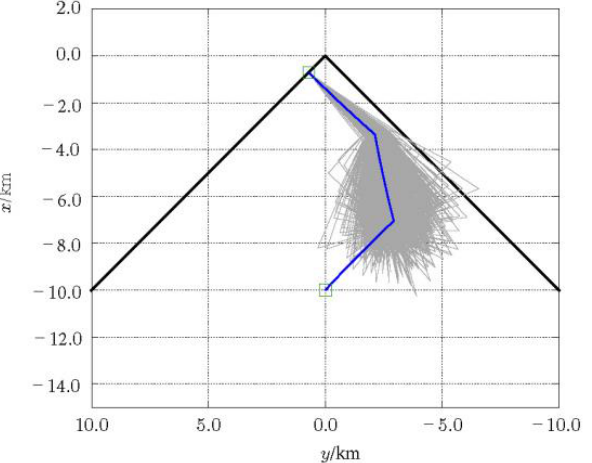
Figure 15. Robust guidance with the SaG strategy case: the Monte Carlo sample trajectories have a spatial deviation from the nominal trajectory and the robust guidance gradually absorbs the large trajectory deviation caused by the drift of the SaG point. The blue line represents the nominal trajectory of the deterministic policy π robust running on the unperturbed environment Env unp . The gray lines represent the Monte Carlo sample trajectories of π robust running on the observation uncertain environment Env obs . It can be seen that the nominal trajectory is a dog-leg one that can improve the range observability of AON. The characteristic of the nominal trajectory is shown in Table 6. It can be seen that the sample trajectories of π det erm running on Env obs have a certain spatial deviation from the trajectory of π det erm running on Env unp , especially at the SaG point, the deviation increases significantly. Specifically, the position deviation of the trajectory at the SaG point increased from 10 m to 1000 m, and the speed deviation increased from 1 mm/s to 5 mm/s. Table 6. The characteristic of the nominal trajectory for π ro b us t .